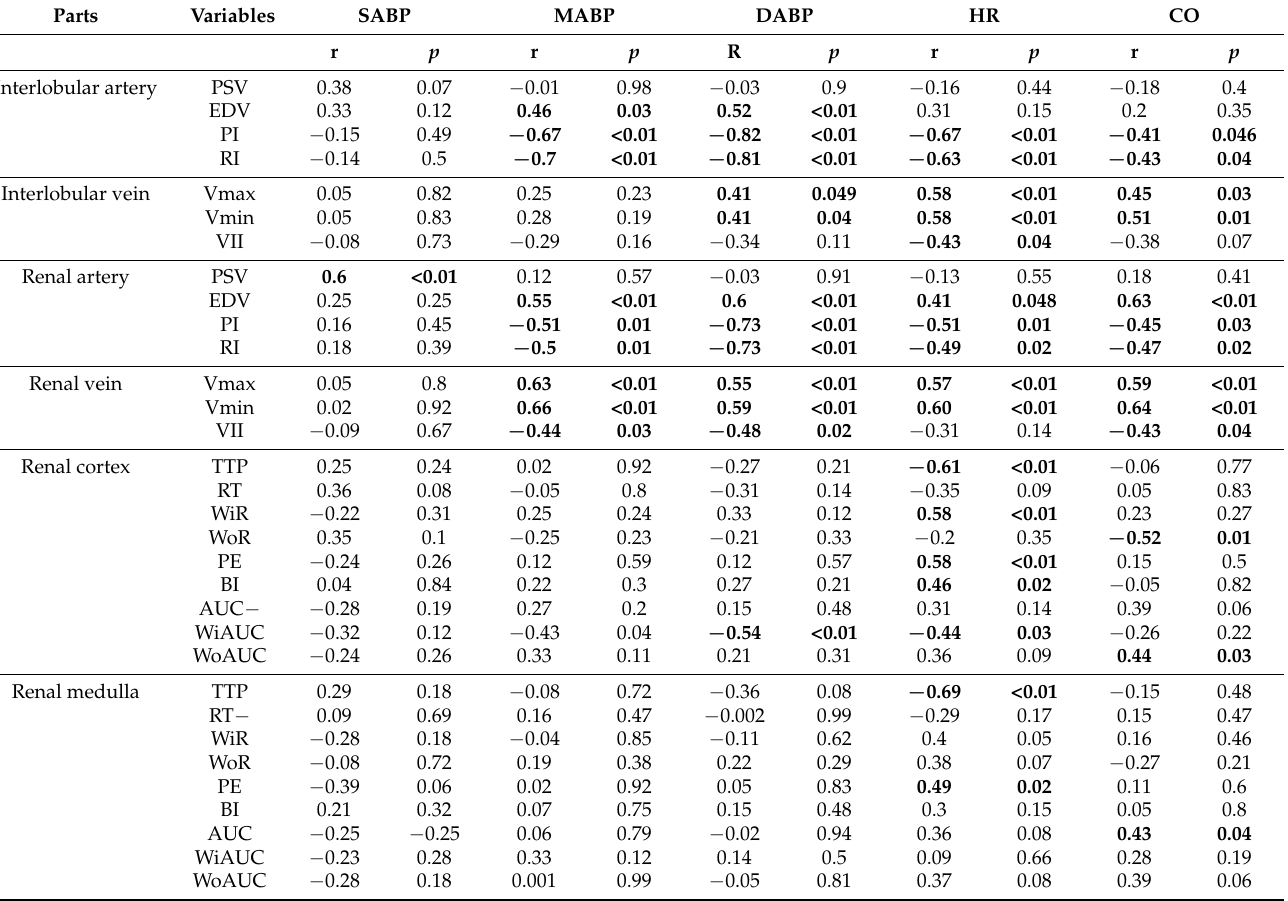
Table 4. Correlation between ultrasonographic parameters and systemic circulation